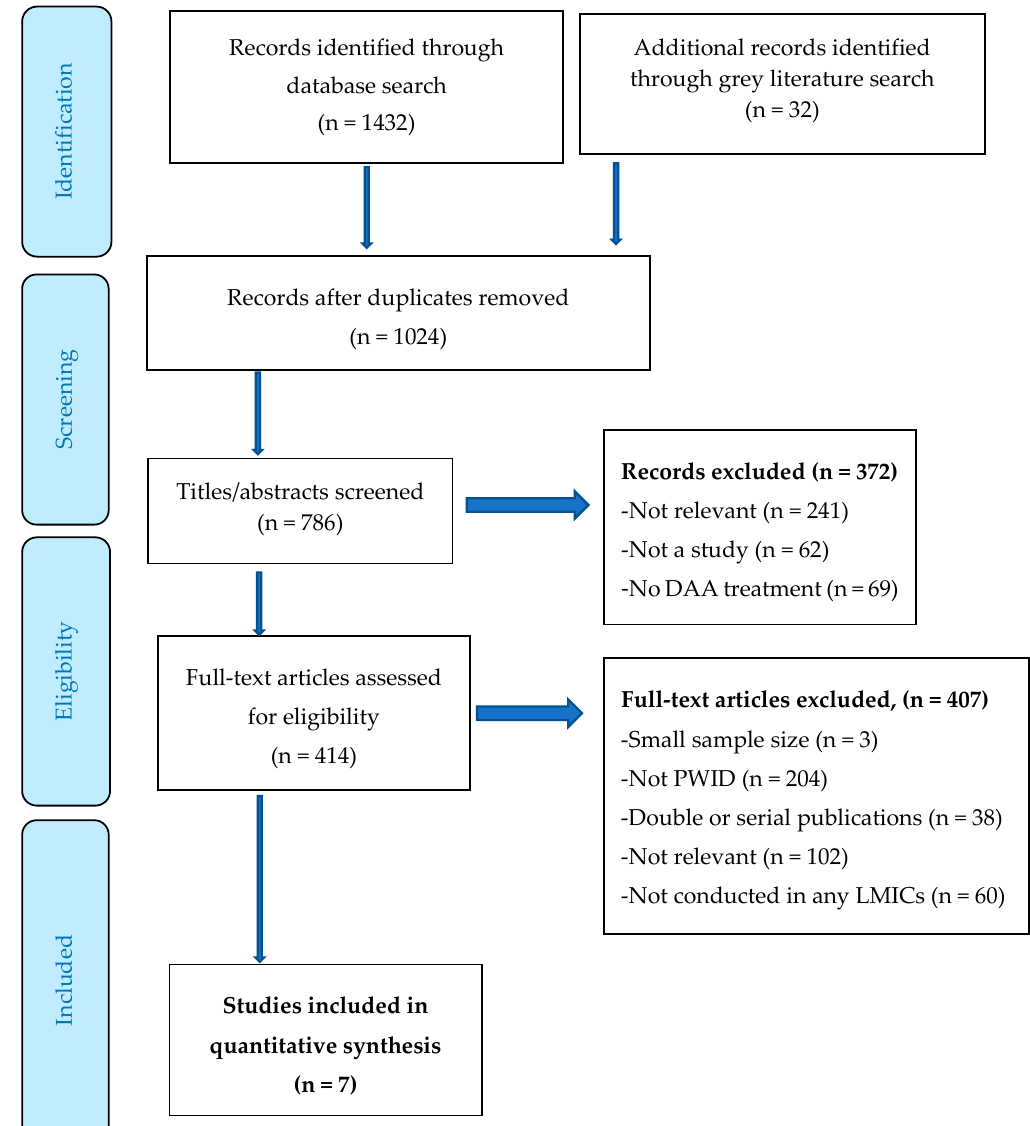
Figure 1. Prisma flowchart.